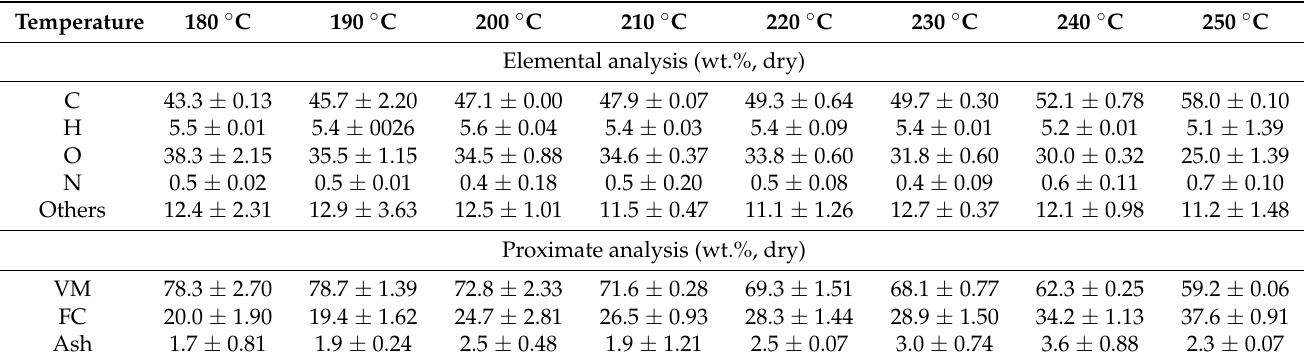
Table 2. Elemental and proximate analysis of EFB according to reaction temperature (EFB:water = 1:8). Temperature